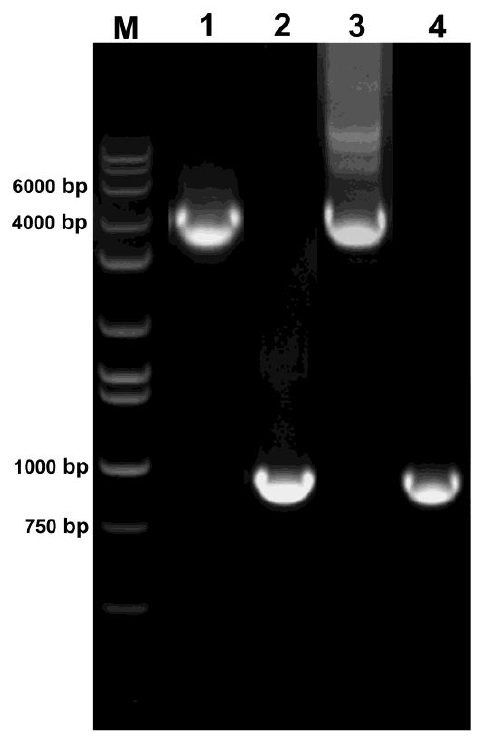
Figure 4. PCR results (representative) from heat-induced and un-induced tobacco and Arabidopsis plants. PCR fragments of size 4,165 bp and 931 bp is expected from un-induced and induced plants, respectively. Similar results were obtained by PCR analysis of several independent lines of tobacco and Arabidopsis . M—HI-LO DNA marker, 1—Tobacco un-induced, 2—Tobacco induced, 3— Arabidopsis un-induced, 4— Arabidopsis